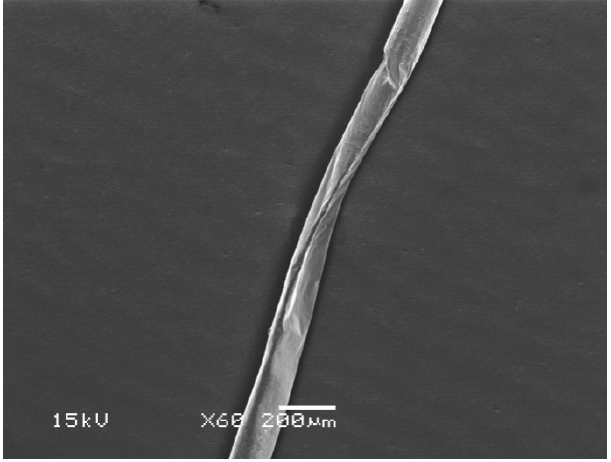
Figure 22. Evidence of wire stress caused by capacitor discharge through wire (note, wire did not ignite).